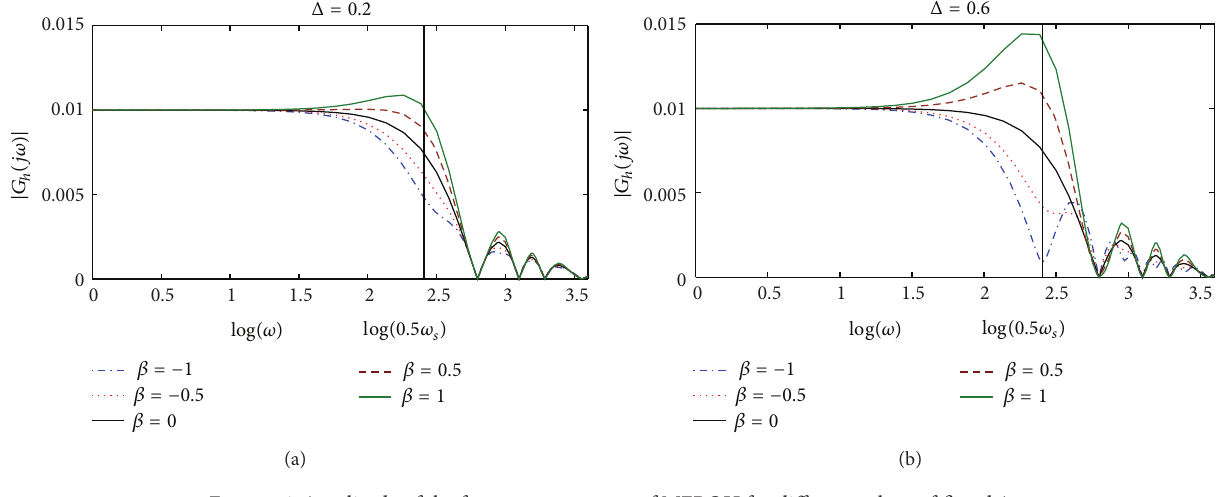
Figure 6: Amplitude of the frequency response of MFROH for different values of 𝛽 and Δ .